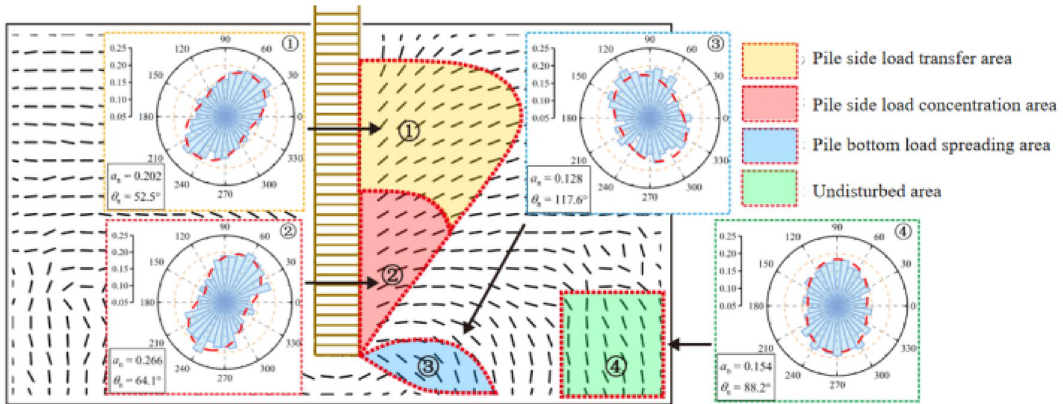
Figure 16. Distribution of the contact normal